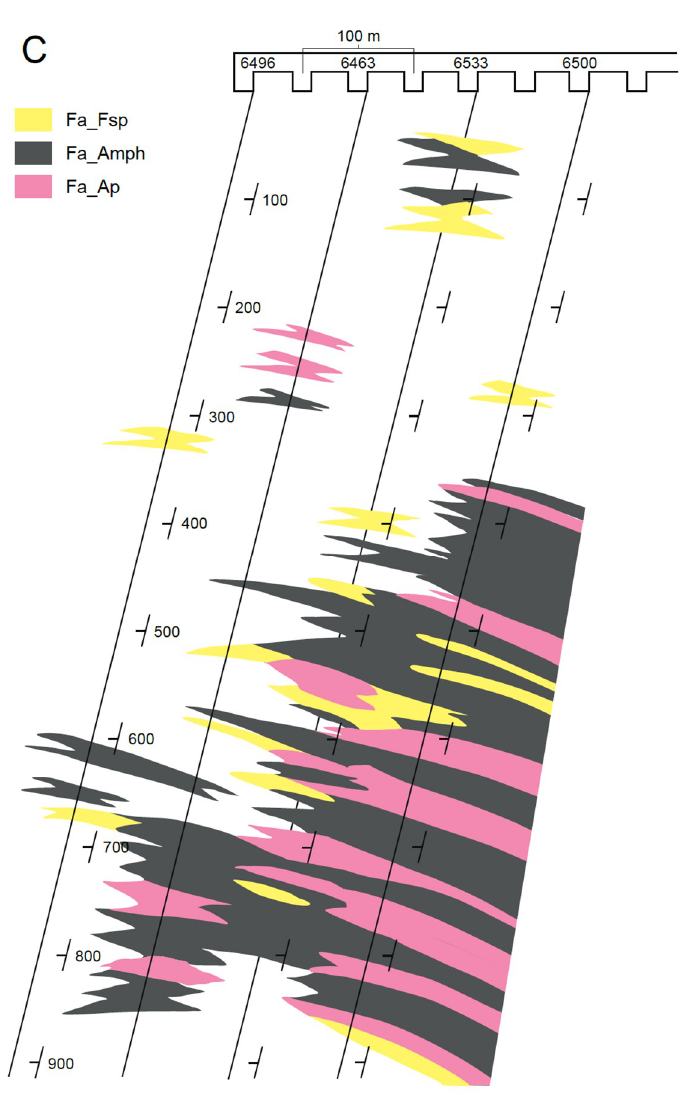
Figure 8. Spatial distribution of textural types in cross-sections (Lund, 2013).